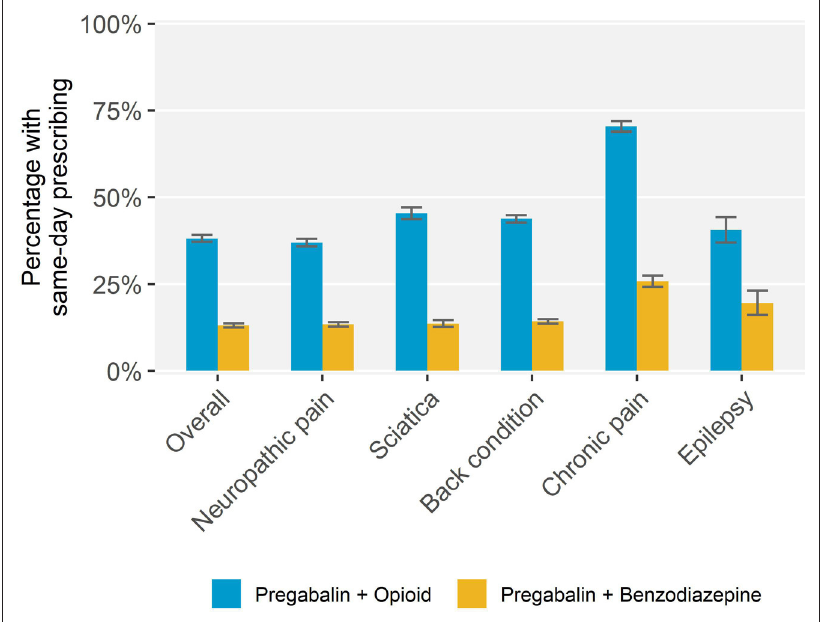
Figure 3 Prevalence of same- day prescribing of pregabalin and an opioid or benzodiazepine by recorded condition among patients prescribed pregabalin for whom capture of same- day prescribing was available,